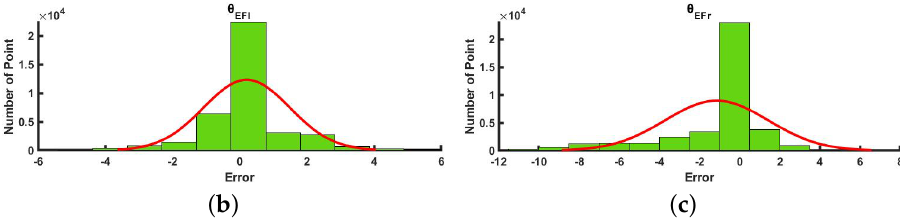
Figure 15. Error statistics of elbow joint angle. ( a ) Frequency histogram of left elbow joints. ( b ) Fre- quency histogram of right elbow